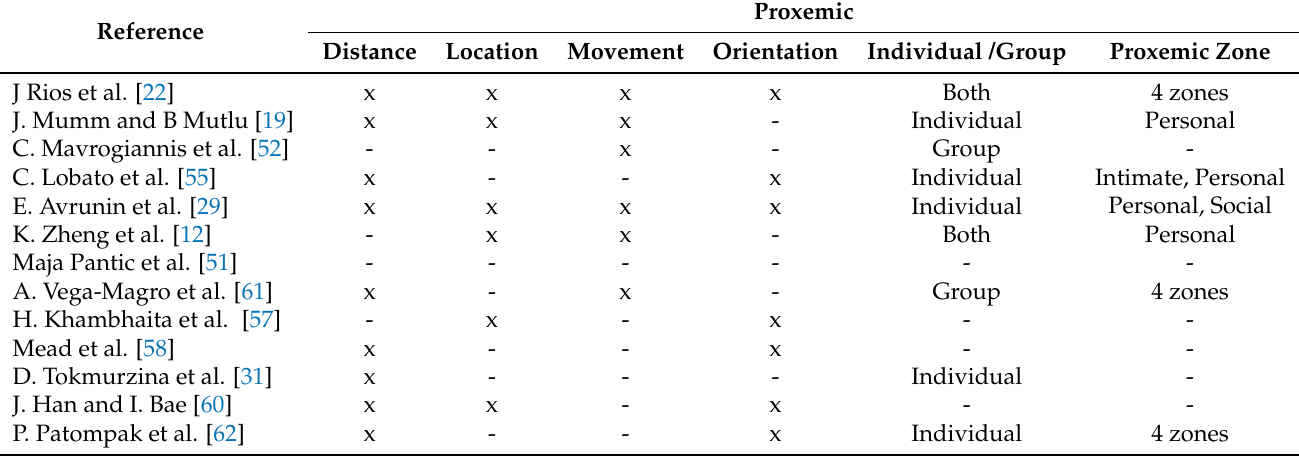
Table 1. Comparative table of studies on social navigation based on